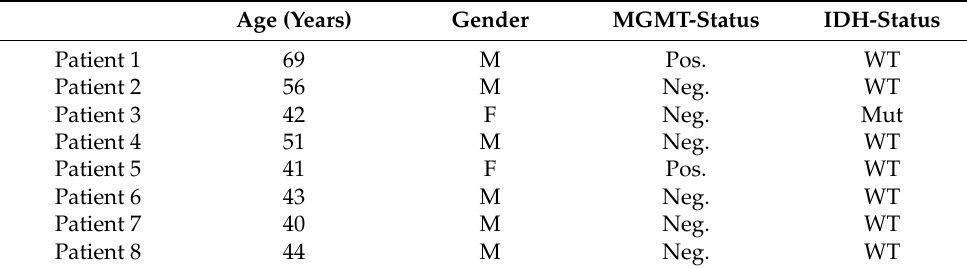
Table 2. Individual patient characteristics.